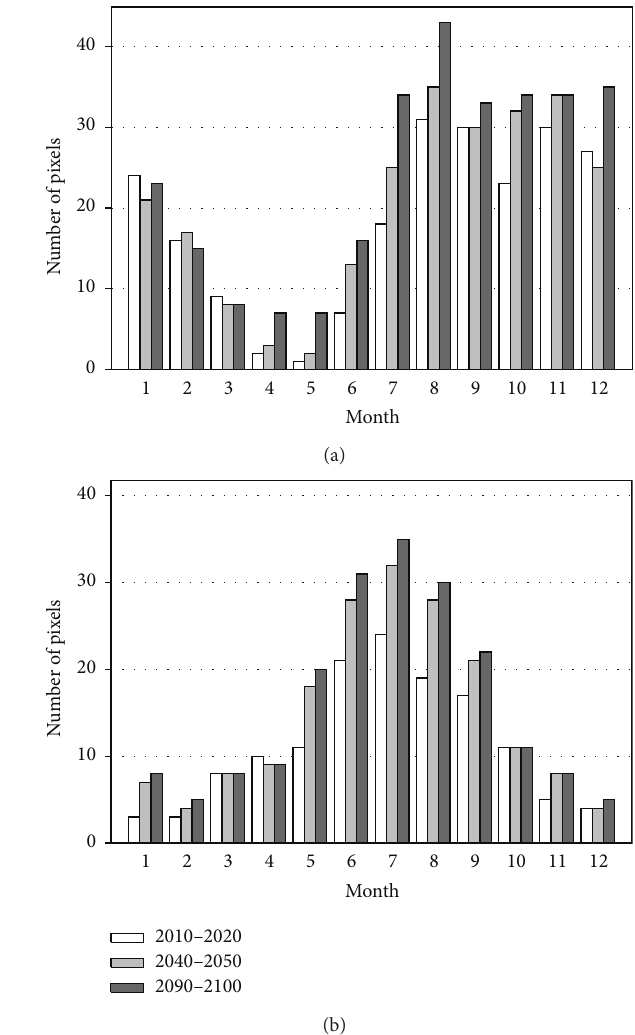
Figure 6: Effects of future urban expansion on average monthly temperature and precipitation in nonurban area in the Northeast megalopolis, USA. (a) Number of pixels with average monthly temperature change exceeding ± 0.5 ∘ C; (b) number of pixels with average monthly precipitation change exceeding ±